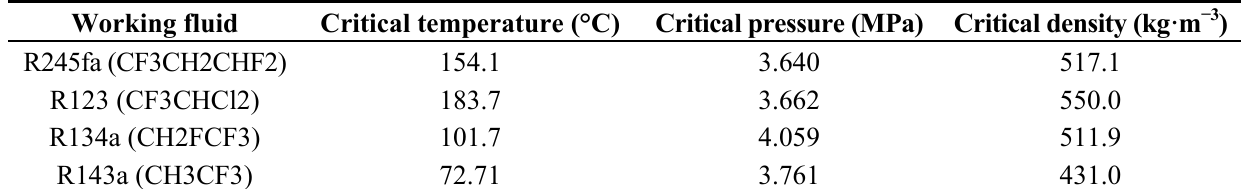
Table 1. Critical parameters of working fluids used in